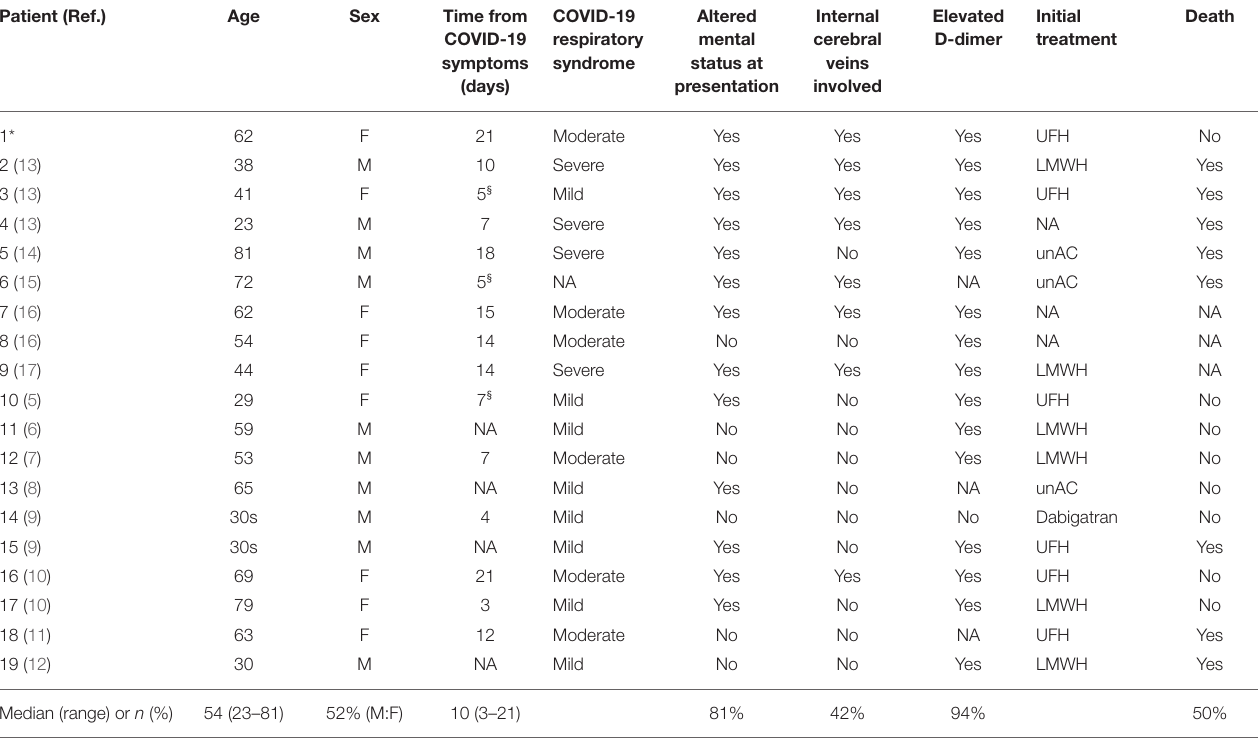
TABLE 1 | Clinical features of reported individual patients with cerebral venous thrombosis related to COVID-19 infection. Patient